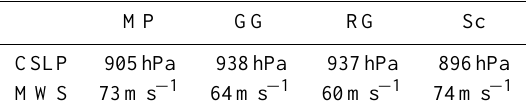
Table 2. Simulated intensity values for MPS experiments on 18:00UTC, 28 October 1999 when(as per the IMD estimate) the storm reached its maximum intensity (912hPa, 72ms − 1 ).